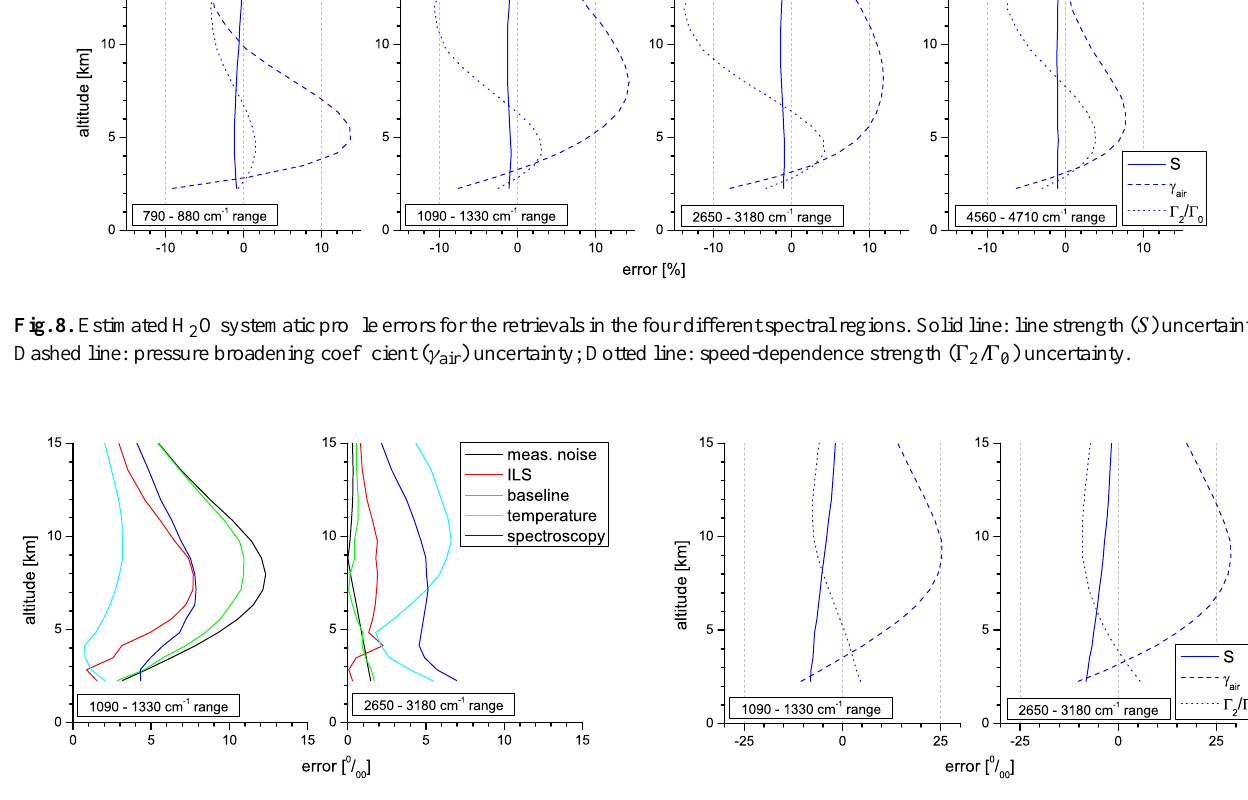
Fig. 9. Same as Fig. 7 but for δ D and the two retrievals at 1090– 1330 and 2650–3180cm − 1 .